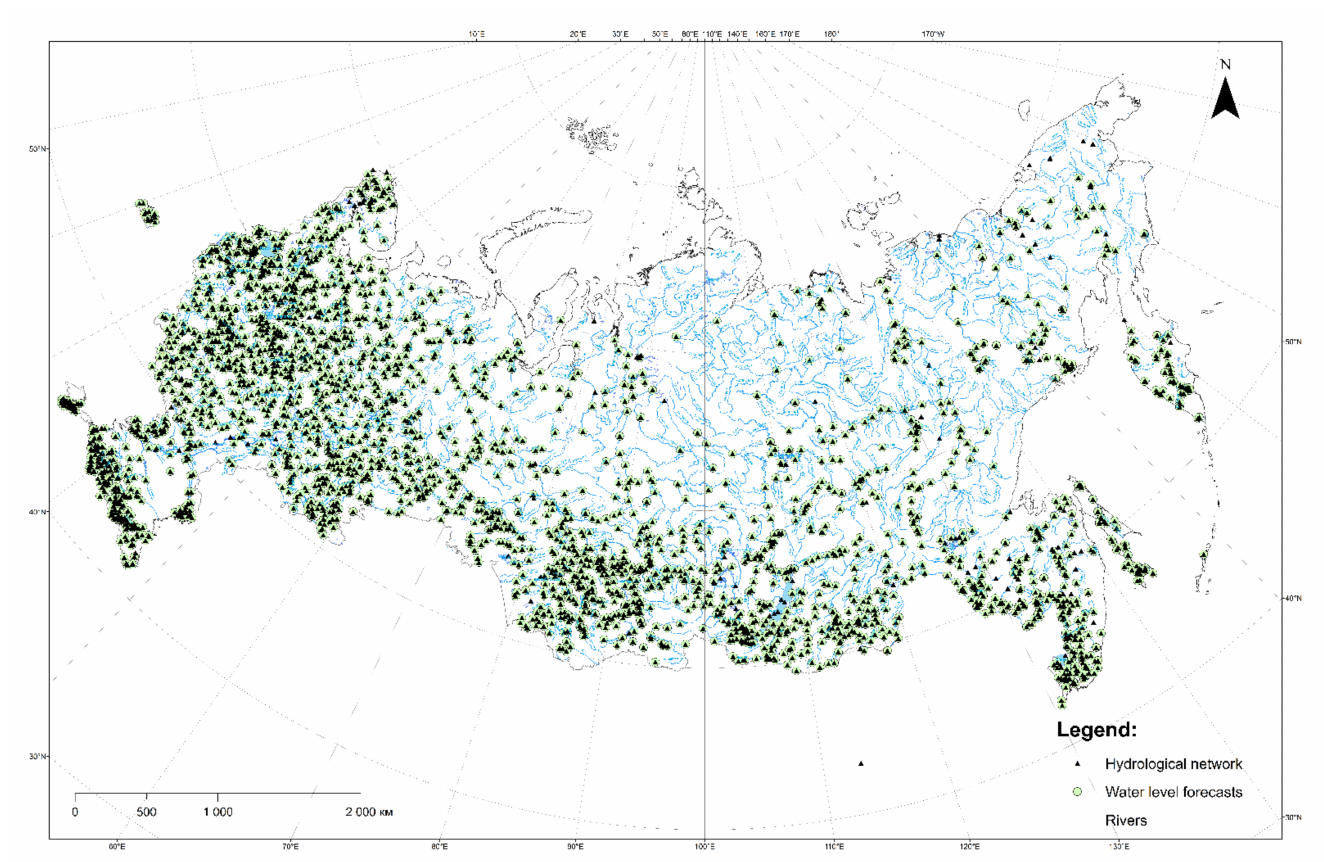
Figure 1. The location of stream gauging stations in Russia and gauges with efficient water level forecasts, based on the proposed